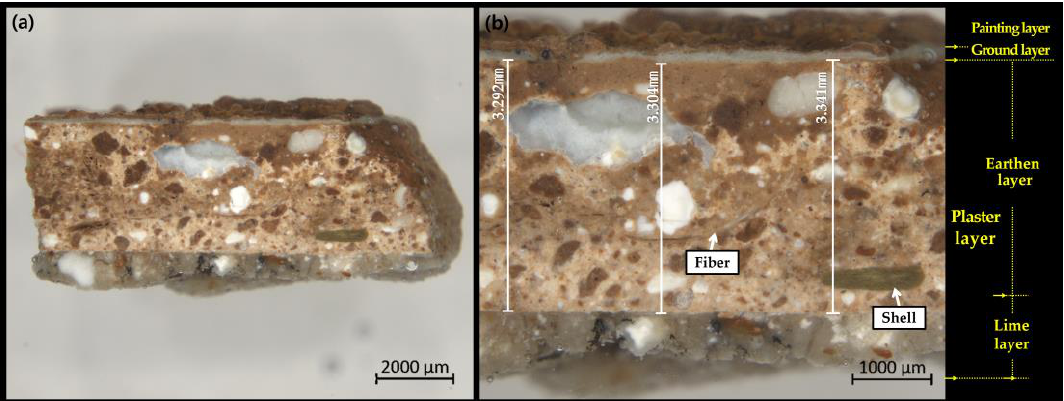
Figure 4. Optical images of cross-sectional mural sample. ( a ) Whole, ( b ) Part.